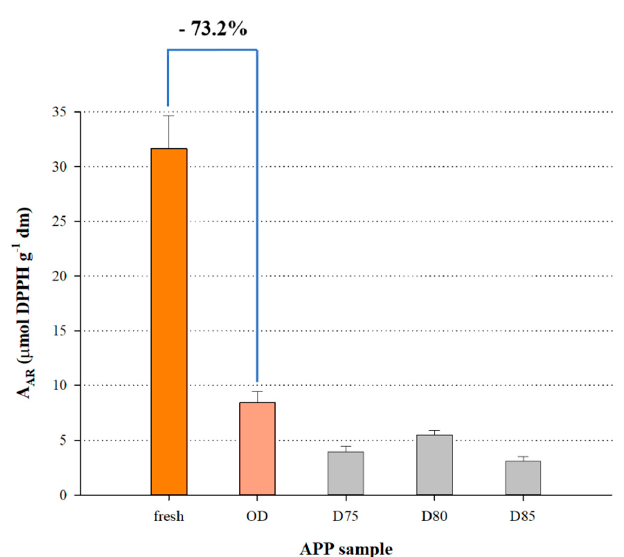
Figure 5. Bar plot showing the effect of APP drying under optimised conditions on the A AR , as compared with the non-dried APP and APP dried at elevated temperatures. Assignments: OD, optimal drying ( t = 8.27 h and T = 70 °C). D75, D80 and D85 correspond to APP drying at 75, 80 and 85 °C, for t = 8.27 h).